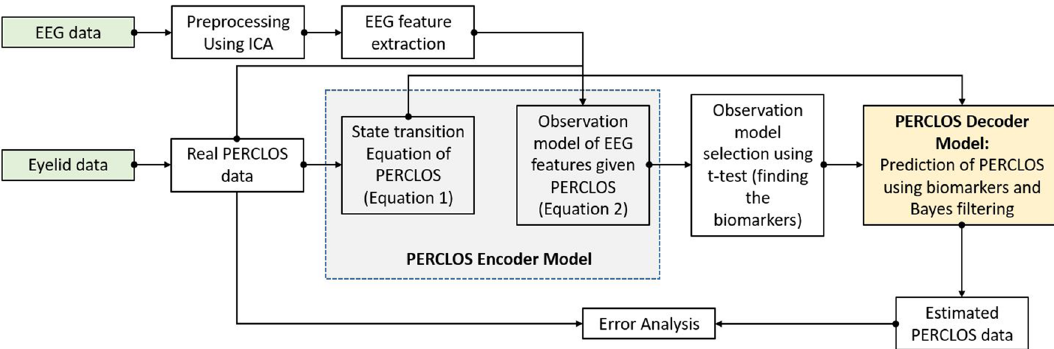
Figure 4. Flowchart of the proposed neural encdoer-decoder modeling framework for PERCLOS. This framework has two main steps: encoder model, and decoder model. In the encoder model, state transition process of PERCLOS and the relationship between every EEG feature and PERCLOS are defined. Biomarkers are obtained using t-test and they are used in the decoder step to predict the PERCLOS in real-time using Bayes